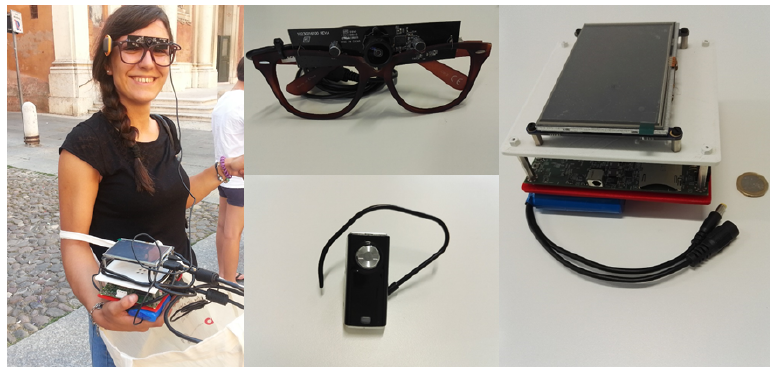
Figure 2. One of the participants in the user evaluation equipped with the hardware